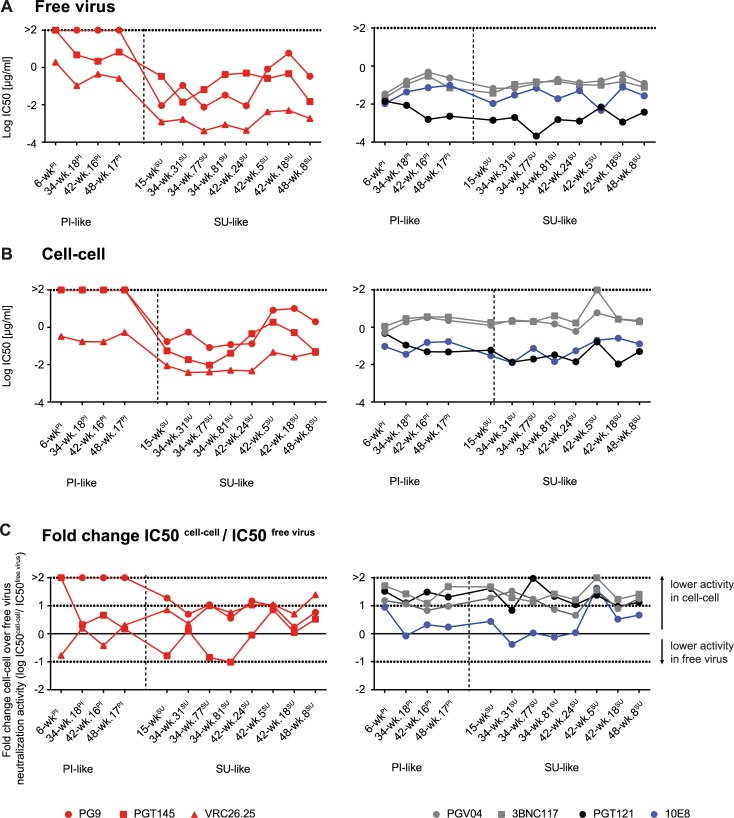
Heterologous bnAbs exhibit different neutralization efficiencies in CAP256 Env free virus and cell-cell transmission A and B: IC50 (in μg/ml) of heterologous bnAbs targeting the V2 apex (red), the CD4 binding site (grey), the V3 glycan supersite (black) or the MPER region (blue) against free virus (A) and cell-cell transmission (B) are shown. Data are means of 2 to 4 independent experiments. C: The change in neutralization activity for cell-cell compared to free virus transmission is displayed as the log of the ratio of IC50cell-cell/IC50free-virus (log fold change). Zero denotes equal activity in both transmission pathways. 10-fold higher (log10 = 1) and lower (log10 = -1) IC50 in cell-cell over free virus transmission are indicated by dotted lines.